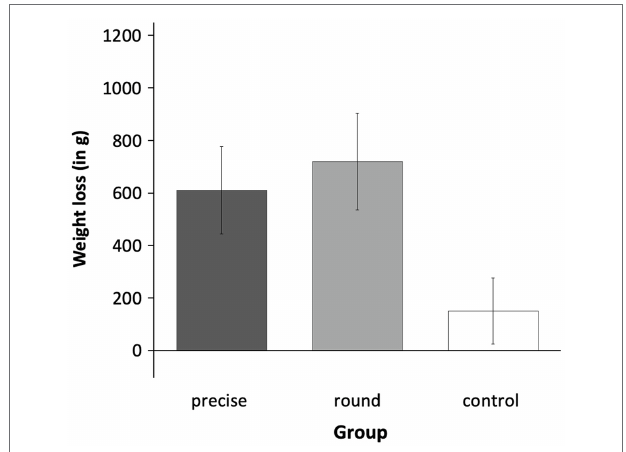
FIGURE 3 | Weight loss across Experiment 1 and Experiment 2. The individual participant data (IPD) meta-analysis showed that across both experiments, the three experimental conditions (precise goal vs. round goal vs. control) differed significantly in weight loss. Contrast analyses showed that both the precise goal and the round goal condition lost significantly more weight than the waiting control group. Error bars represent ±1